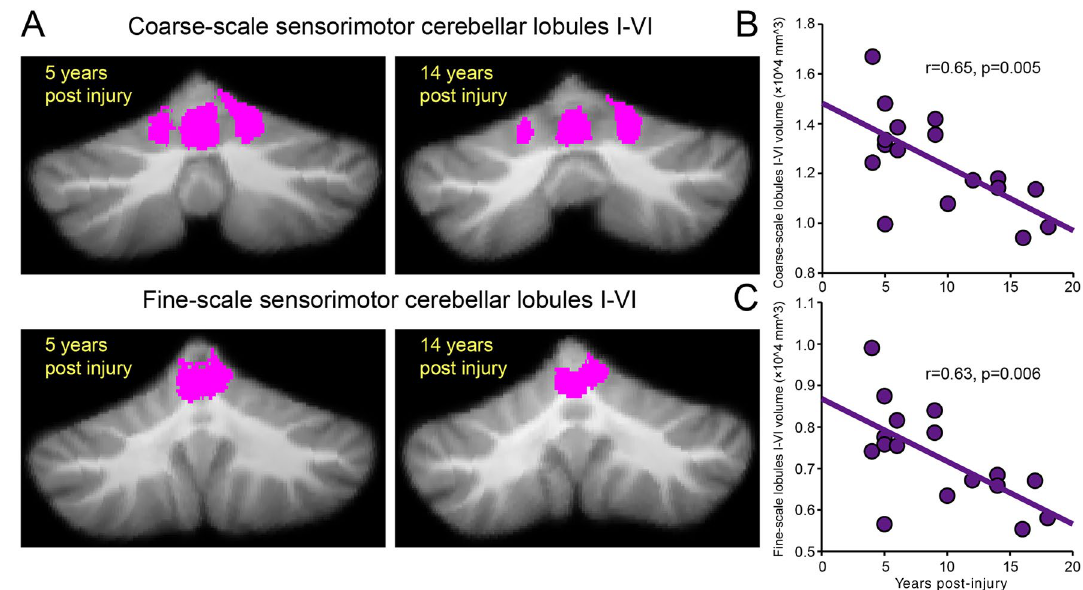
Figure 5. Cerebellar changes and time post-injury. ( A ) Coarse- and fine-scale sensorimotor regions in anterior and posterior cerebellar lobules identified in SCI subjects (SCI = 17) with 5 years post-injury (left column) and 14 years post-injury (right column). ( B , C ) Graphs show a correlation between the time post-injury and the volume of the sensorimotor cerebellum in SCI subjects. Note that SCI subjects with increasing time post-injury were those with smaller volume in the coarse- and fine-scale sensorimotor cerebellar lobules I–VI. *p <